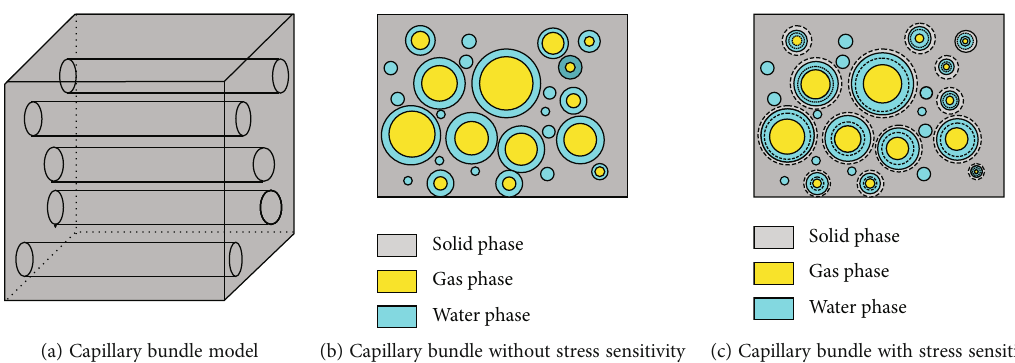
Figure 1: The distribution of gas and water in capillary bundle model